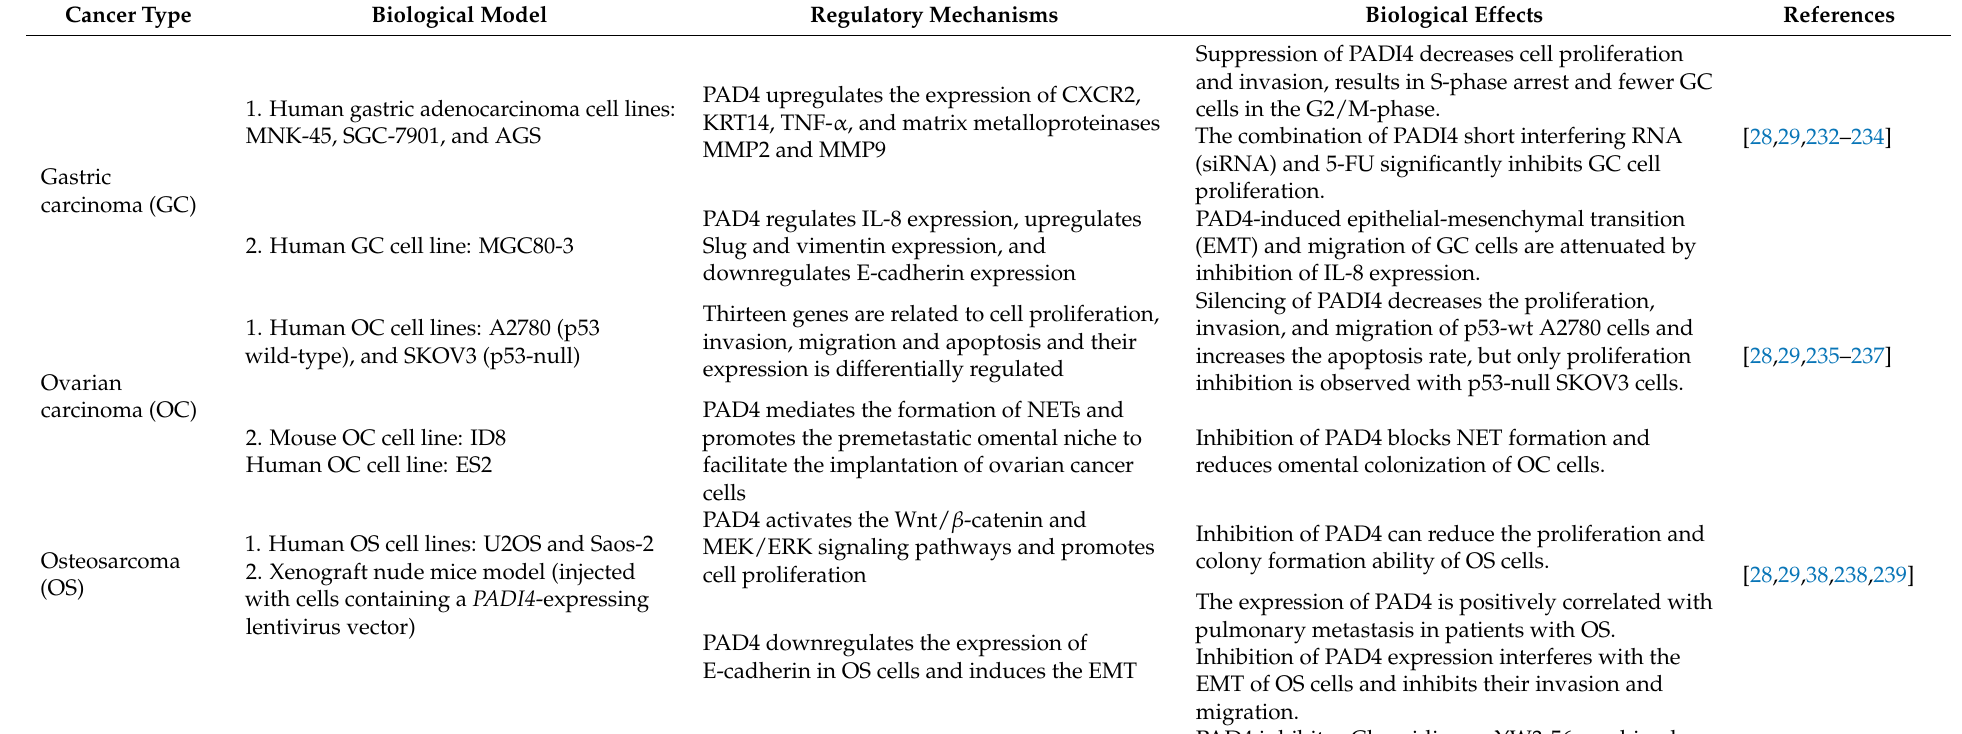
Table 2. The potential role played by PAD4 in cancers and the associated mechanisms of PAD4